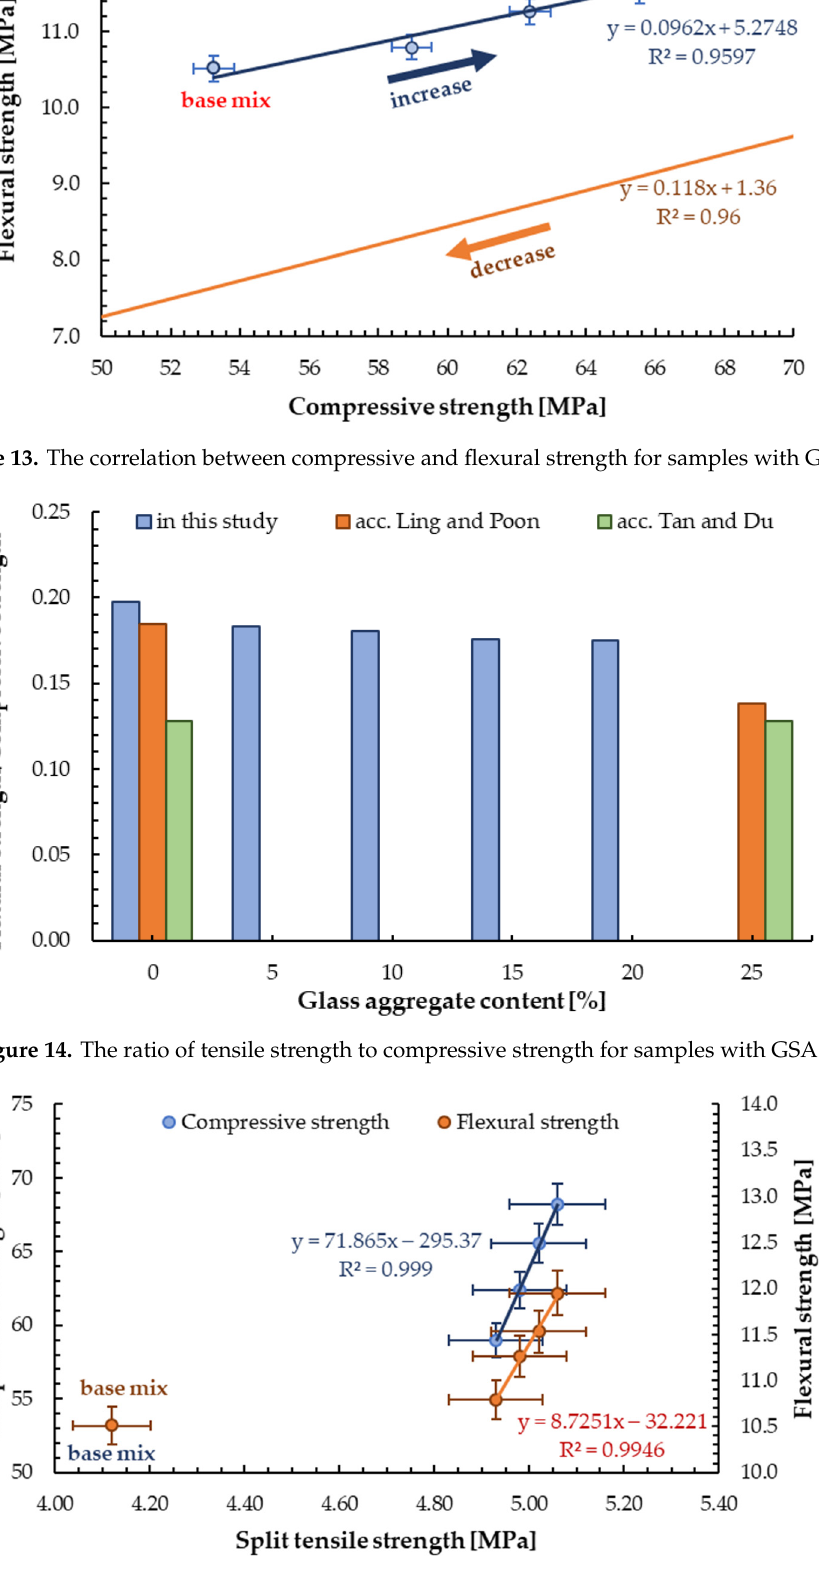
Figure 15. Relationships between mechanical properties of mortar containing glass sand aggregate.